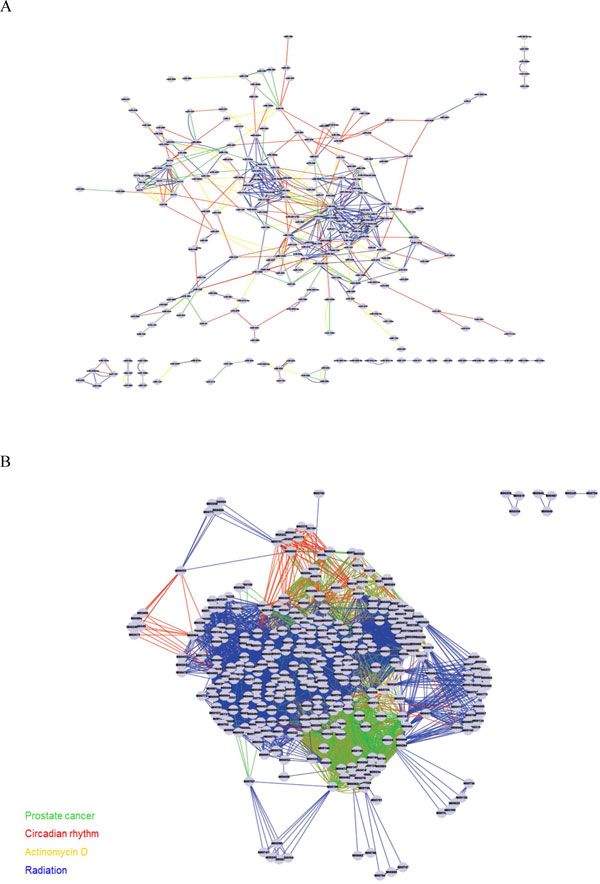
Global MRAN and co-occurrence graph of regulators on MRAN. (A) Global MRAN. Nodes of the network represent miRNAs, and edges represent condition-specific cooperativity between a miRNA pair. (B) Co-occurrence graph of regulators on MRAN. In the co-occurrence graph of regulators on MRAN, nodes represent transcription factors (TFs), and edges statistical significance of co-occurrences. The colors of edges indicate different conditions (red: circadian rhythm, blue: radiation treatment, yellow: Actinomycin D treatment, green: prostate adenocarcinomas).